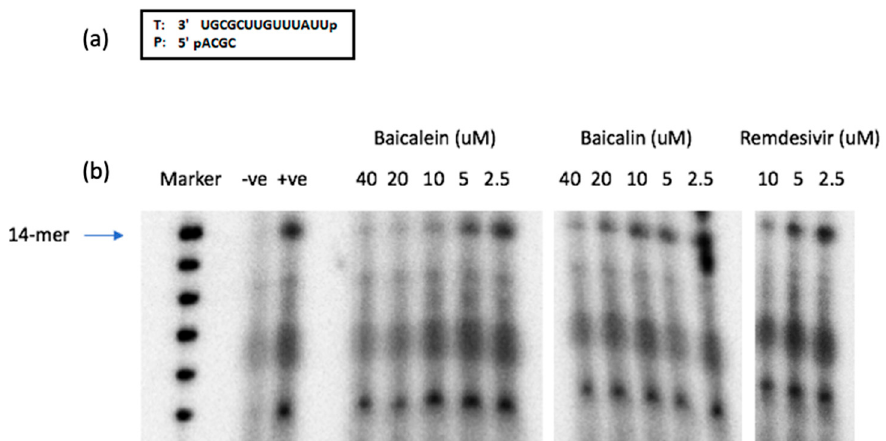
Figure 4. Inhibition of RNA-dependent RNA polymerase activity by baicalein, baicalin, and RDV-TP. ( a ) RNA 4-mer primer/14-mer template used in the RNA polymerase reaction. ( b ) Full-length 14-mer RNA product synthesis by SARS-CoV-2 polymerase complex (nsp12/nsp7/nsp8) in the presence/absence of indicated concentrations of each compound. (-ve) is the control without RdRp complex. (+ve) is the no-treatment control for the reaction. (Marker) is the molecular size marker.